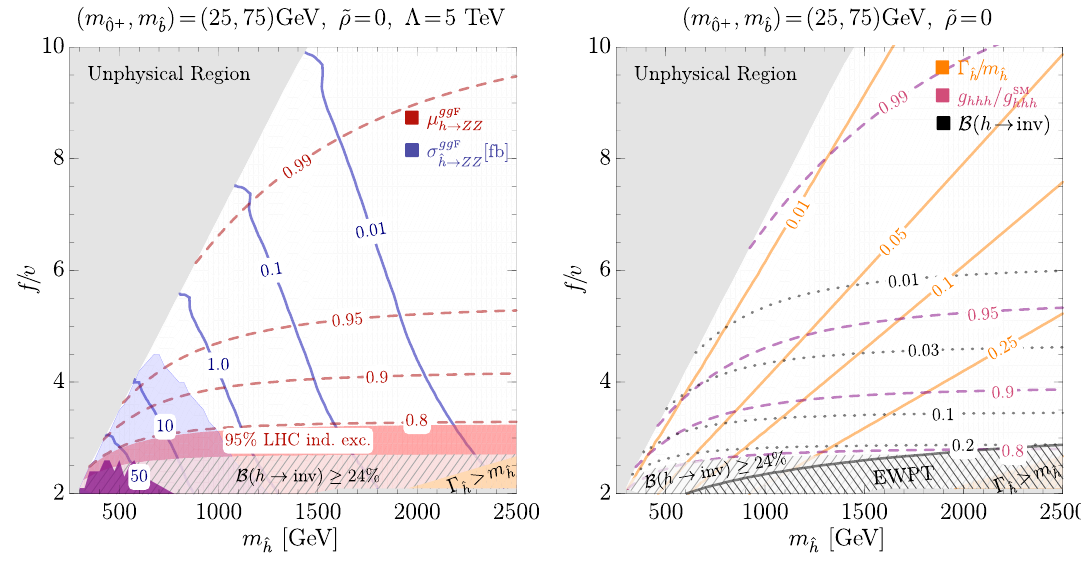
Figure 15 . The left-panel shows the contours of the cross-section of the heavy Higgs to the SM vector bosons (solid blue) and the SM Higgs signal-strength (dashed red) in m ^ the FTH model with ~ (cid:26) = 0. The right-plot show the contours of the ratio of heavy twin Higgs width over mass, (cid:0) ^ =m ^ (solid orange), the ratio of the SM-like Higgs trilinear coupling over its h h corresponding SM values, g hhh =g sm (dashed purple), and the SM Higgs invisible (twin) branching hhh fraction B ( h ! inv : ) (dotted). For these plots we take the twin glueball mass m ^0 and the twin bottom quark mass m ^ = 75 GeV, whereas the details of shaded regions are given in b the